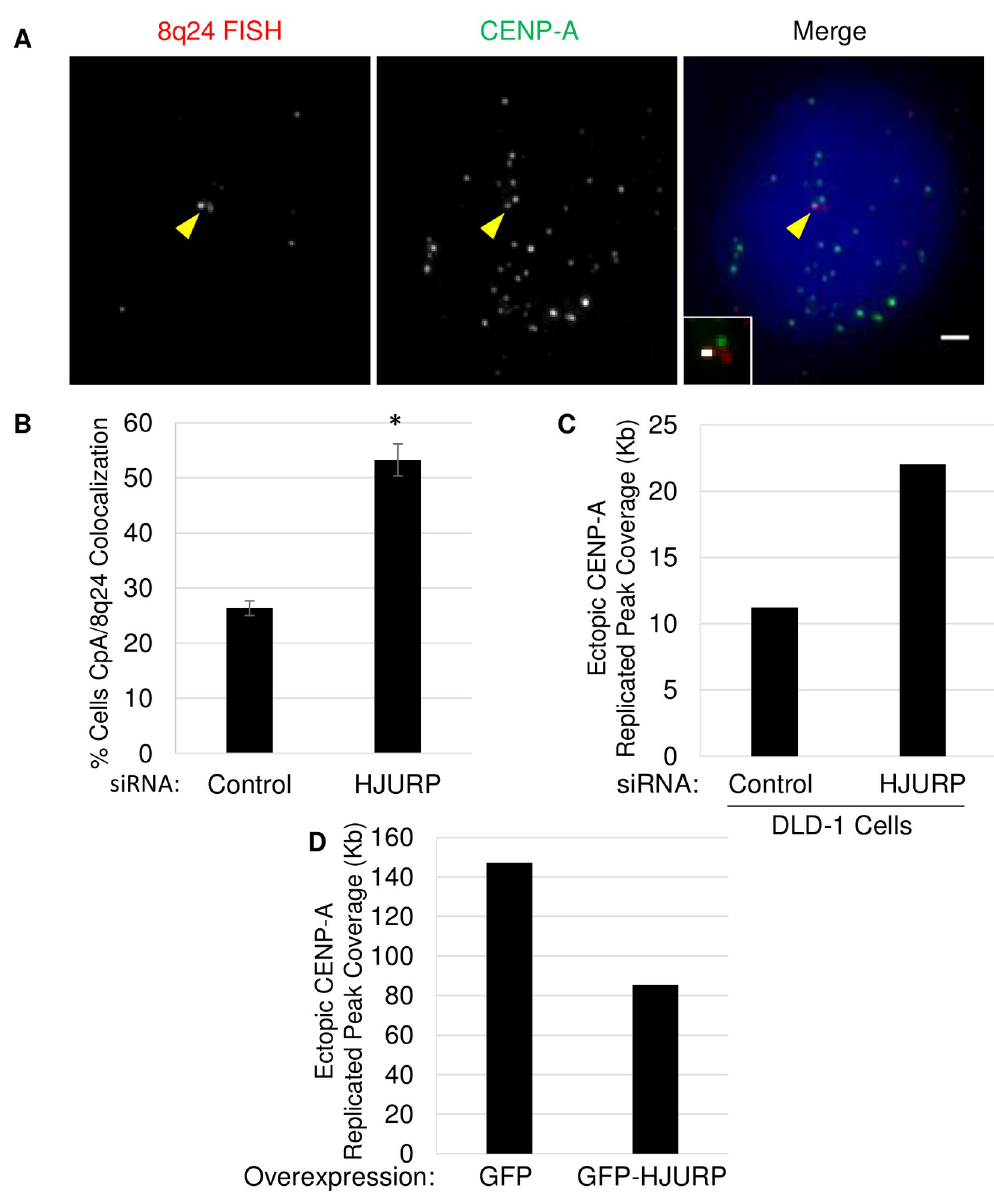
Fig 3. Balance of HJURP and CENP-A required to prevent ectopic localization. A.) FISH for the 8q24 locus and IF for the CENP-A protein was performed on SW480 cells. DAPI in blue. Yellow arrowheads indicate colocalization. Inset shows automated co-localization analysis performed using Image J; white is indicative of co-localization. Scale bar indicates 1 μ m. B.) Graph showing the results of a 72 hour knockdown of the indicated protein on colocalization of CENP-A/8q24 ( � indicates P-value < 0.01, Students t-test). Error bars indicate SEM from 3 experiments. N > 200 cells per knockdown. C.) Graph showing the results from duplicate CENP-A ChIP-seq experiments in which cells were treated with siRNA against control or HJURP for 72-hours. Each bar represents replicated peak coverage as shown in Fig 1A. D.) Graph showing replicate peak coverage from duplicate CENP-A ChIP-seq experiments performed in stable SW480 cell lines expressing either GFP or